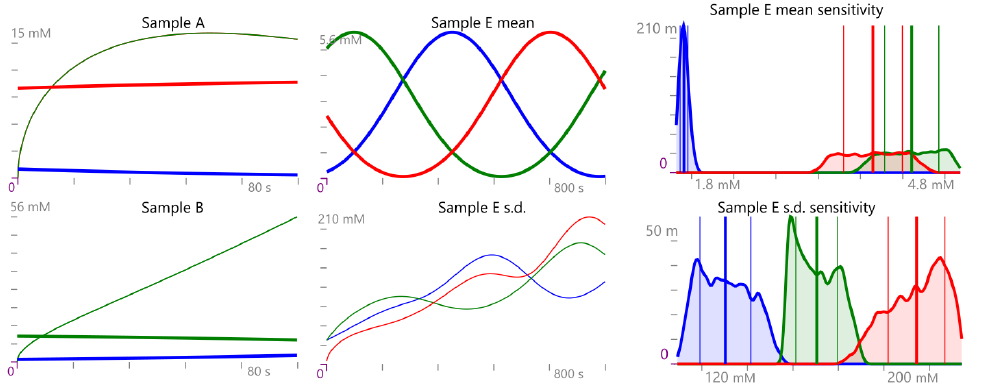
Figure 5. ( Left, Center: ) Evolution of a (red), b (green), c (blue) for protocol P split & mix , showing mean (thick lines) and standard deviation (thin lines), separately for Sample E, with some trajectory overlaps in Sample A and B. Horizontal axis is time (s), vertical axis is concentration (mM). Sample A is simulated first, then Sample B, and finally Sample E, where the standard deviations start above zero due to propagating the final states of the earlier simulations. ( Right: ) Density plots for global sensitivity analysis over 3000 runs, displaying the sensitivity at the end of the protocol of mean ( top ) and standard deviation ( bottom ) of a , b , c . Sensitivity is with respect to the three Equilibrate duration parameters and the Split proportion parameter: those parameters are simultaneously drawn from uniform distributions, each varying by up to ± 5%. Horizontal axis is concentration (mM), vertical axis is the kernel density estimate ( m = × 10 − 3 ) with a standard normal distribution kernel, and bandwidth of 1/100 of the data range. Thick vertical lines locate the mean, thin vertical lines locate the ± standard